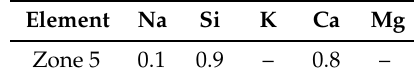
Figure 7. BSE image from 21-day-old mortar in the top left section of specimen. Table 7. EDX chemical analysis of zone 5 marked with * in Figure 7.